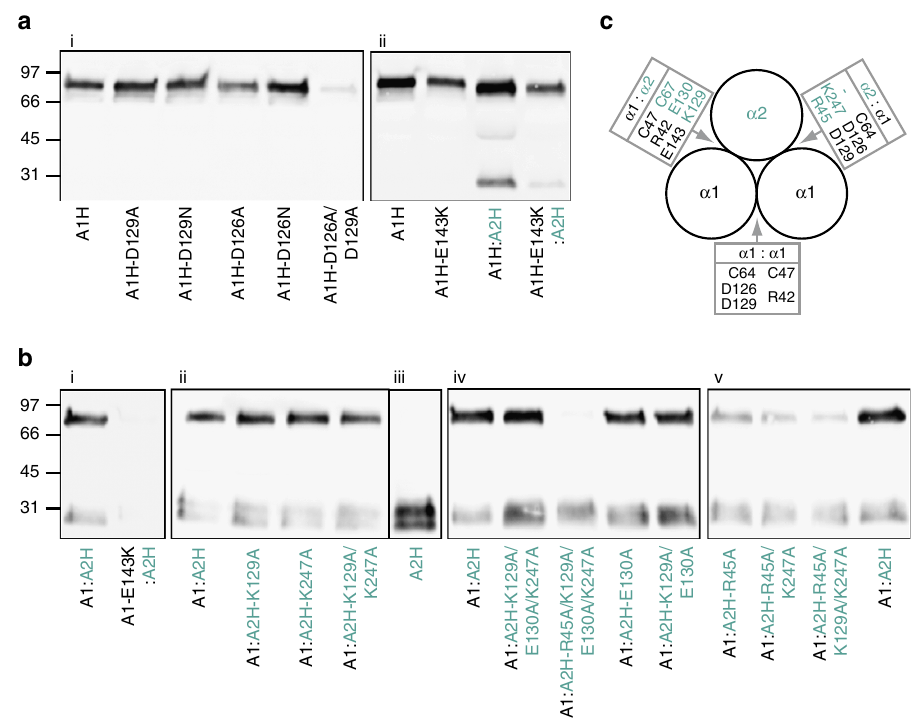
Figure 4 | Effects of site-directed mutations on the trimerization of homo-CPI and hetero-CPI. Proteins secreted into the culture medium after site-directed mutagenesis of the residues indicated were detected by western blotting using the N-terminal His-tag present on either or both the a 1(I) and a 2(I) chains, as indicated by H (for example, A1H means His-tagged a 1 chain). The a 2(I) chain is indicated by the green/blue colour. Gels were run in non- reducing conditions, where trimers migrate at 85kDa and monomers at 30kDa. ( a ) Controls and mutants using the His-tagged a 1(I) chain. ( b ) Controls and mutants using the non-tagged a 1(I) chain and the His-tagged a 2(I) chain. ( c ) Schematic view down the axis of a C-propeptide heterotrimer showing interacting residues at the homo- and hetero-chain interfaces. Same colour coding throughout. Data shown are representative of triplicate ( a ) or duplicate ( b ) biological replicates.